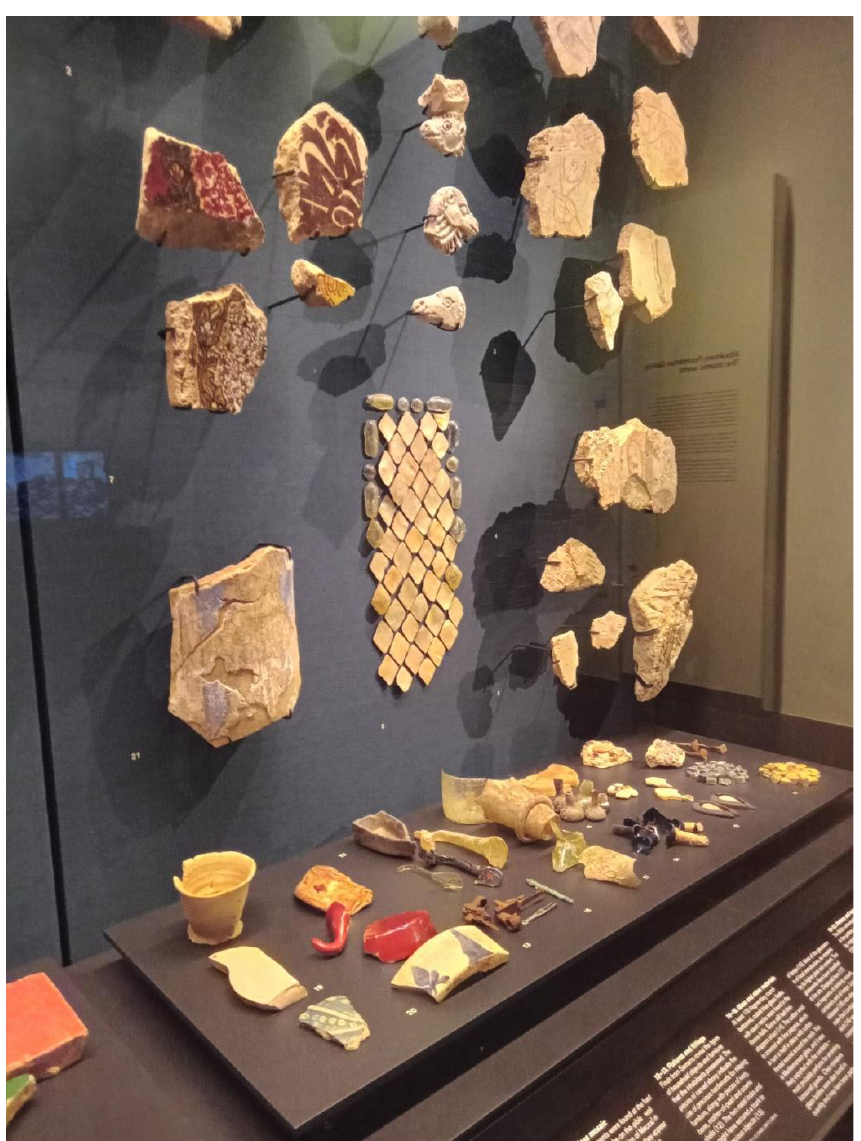
Figure 12. Close up of an archaeological display. The Albukhary Gallery, British Museum. Photos of the author.